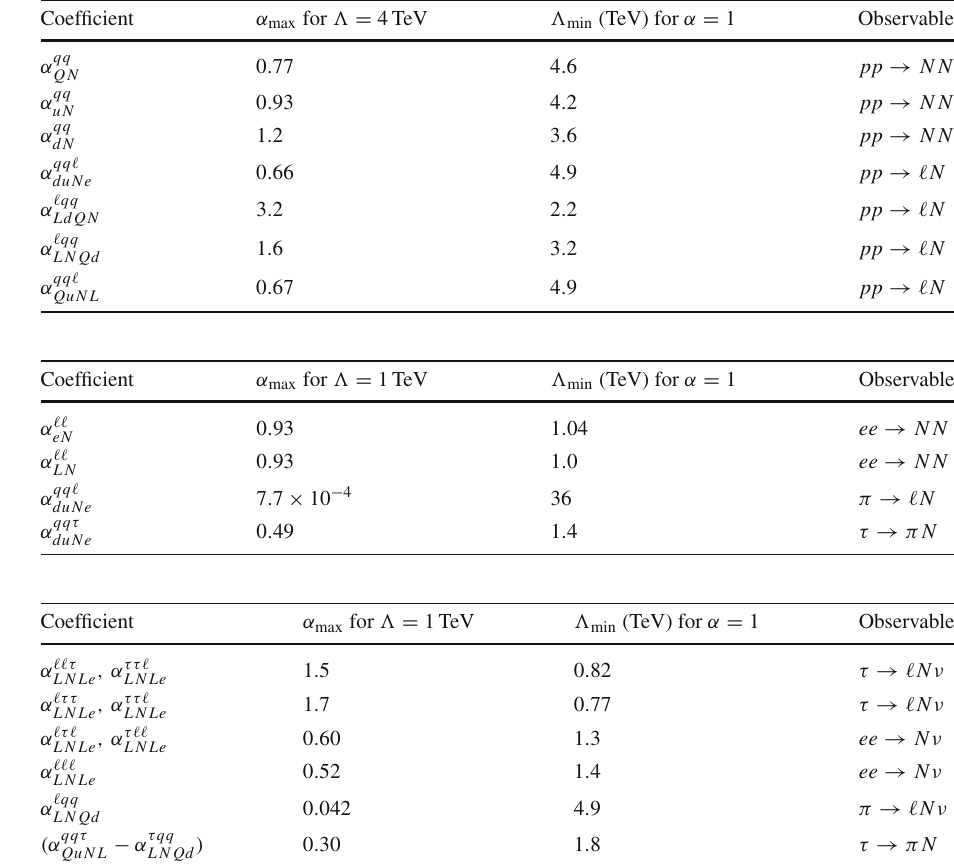
Table 9 Summary of limits on four-fermion operators from LHC processes and observables they result from. Note that